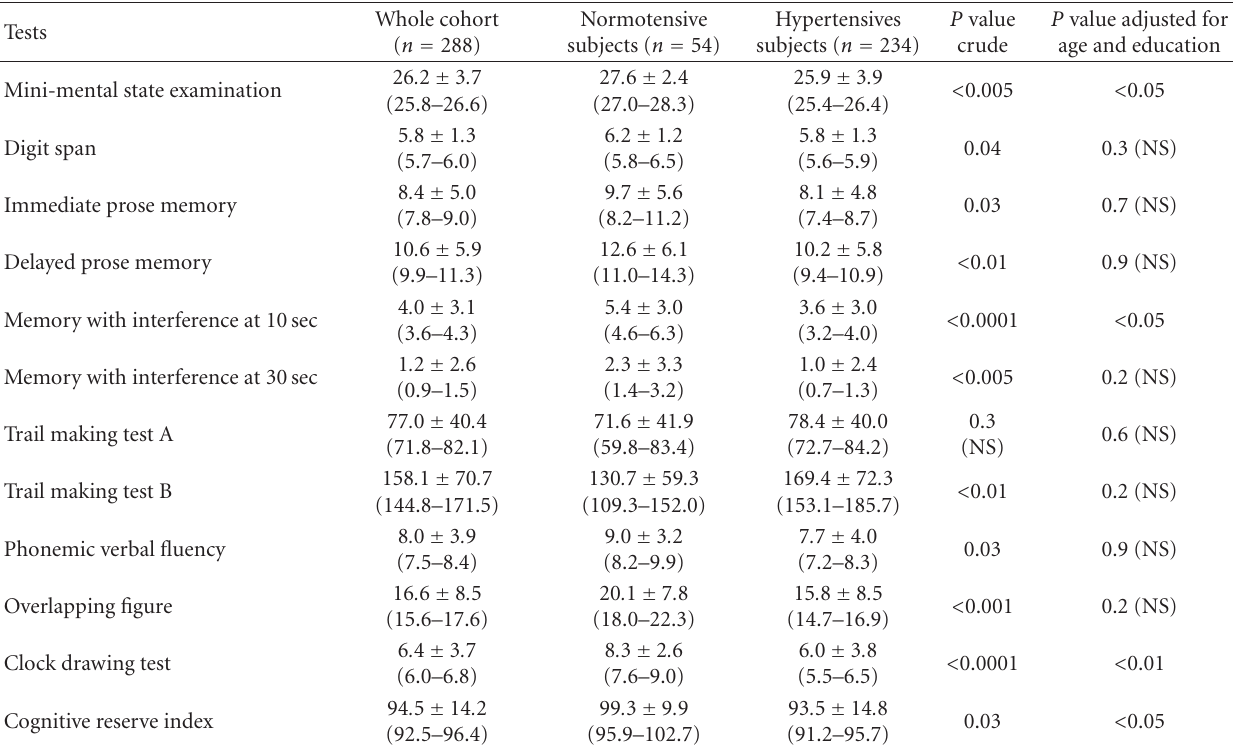
Table 3: Cognitive tests scores by blood pressure value adjusted for age and